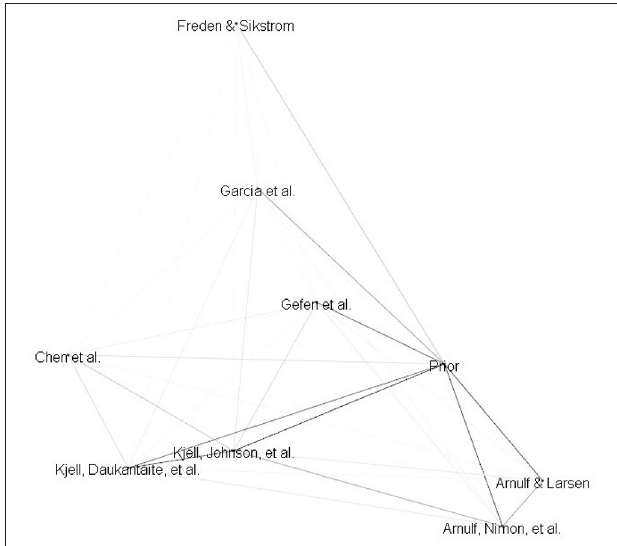
FIGURE 1 | 3D-Plot of Research Topic and prior literature abstracts semantic similarity. Prior encompasses the literature reviewed in the editorial not including the articles contributing to the Research Topic. Darkness of lines represents the magnitude of the cosines resulting from conducting LSA on the abstracts in the Research Topic and prior